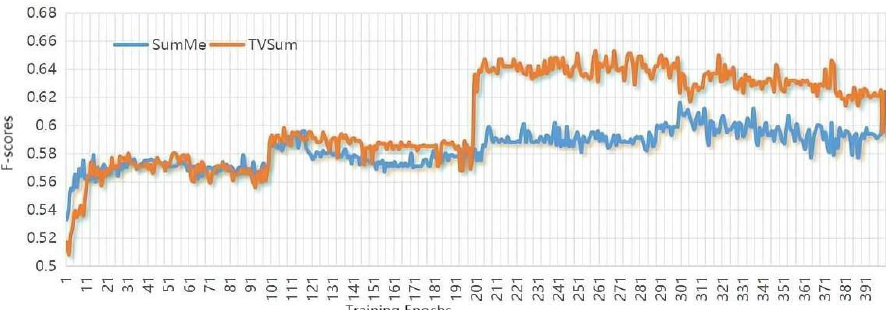
Figure 4. Plots show the influence of training epochs on the value of F-scores.